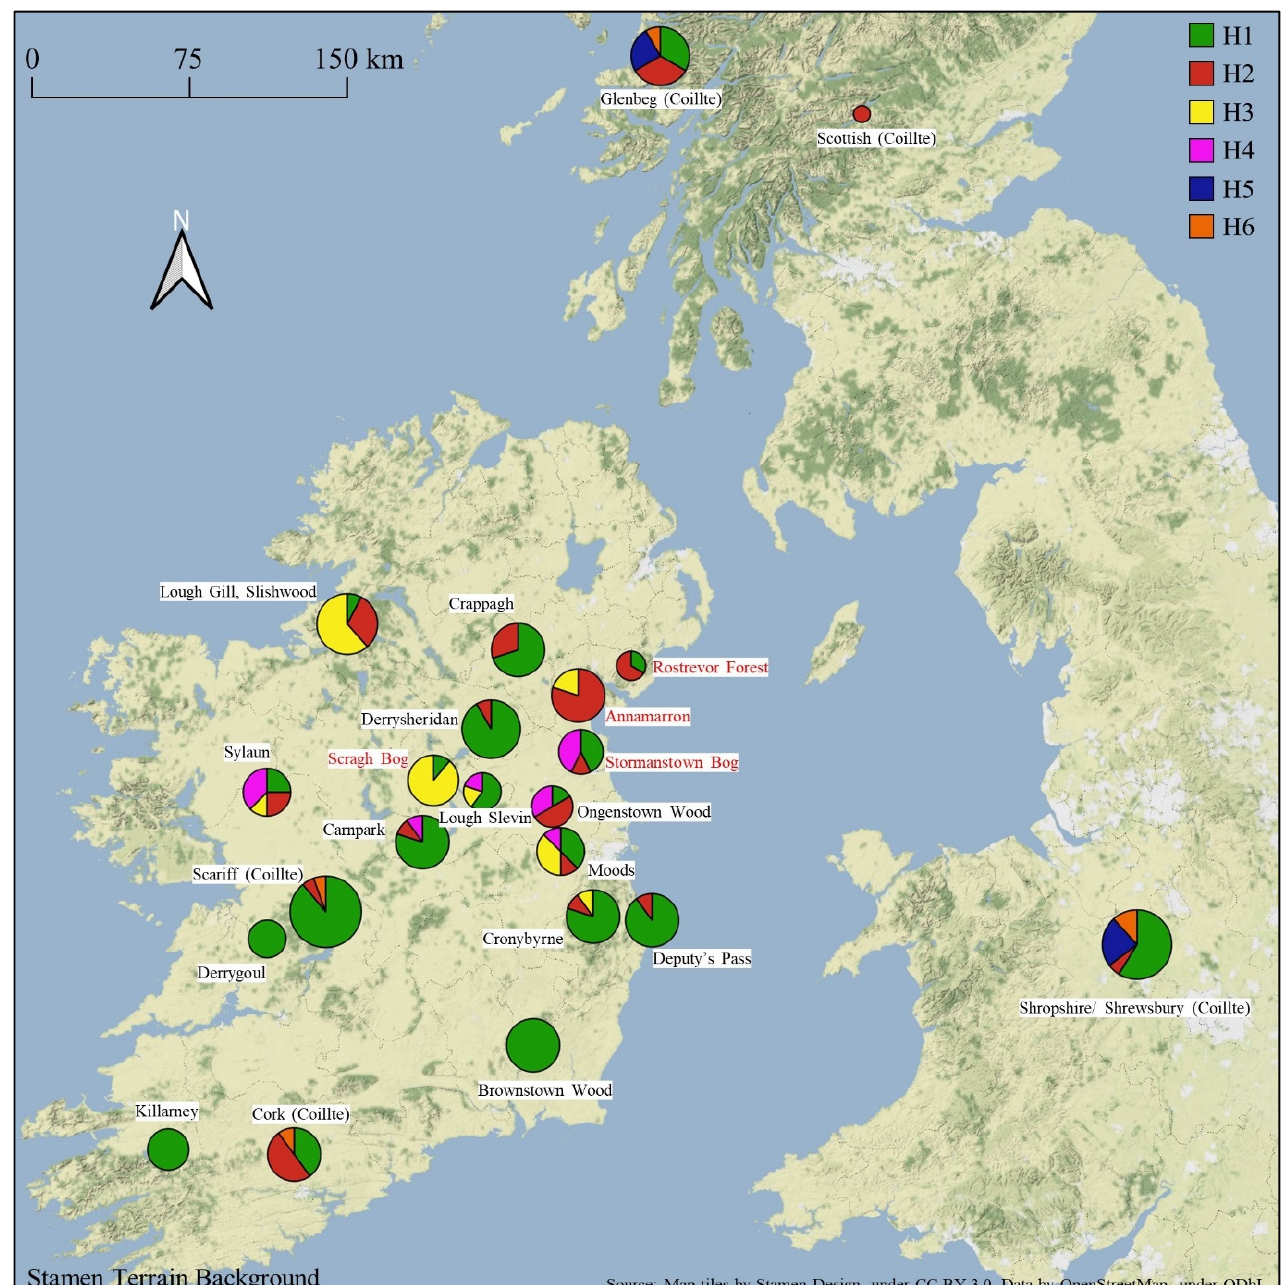
Figure 3. Geographic distribution of the six main haplotypes (those which occurred five or more times) identified in this study. Pie chart size corresponds to the number of each haplotype which could be identified in a particular population. Colours correspond to the different haplotypes (H1 to H6). Names highlighted in red are sites which appeared more genetically differentiated relative to each other and to the other populations (Figure 5 and Figure 6).